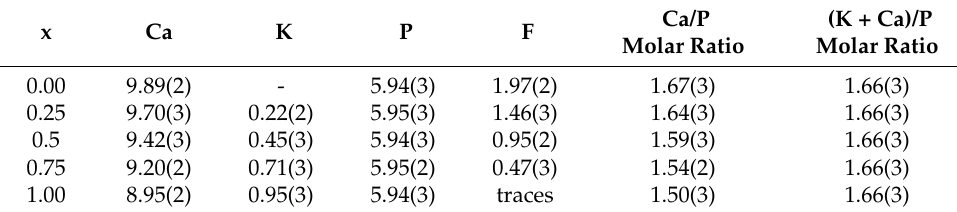
Table 2. Chemical analysis results in mmol/g of Ca 10 − x K x (PO 4 ) 6 F (2 − 2 x ) (OH) x for 0 ≤ x ≤